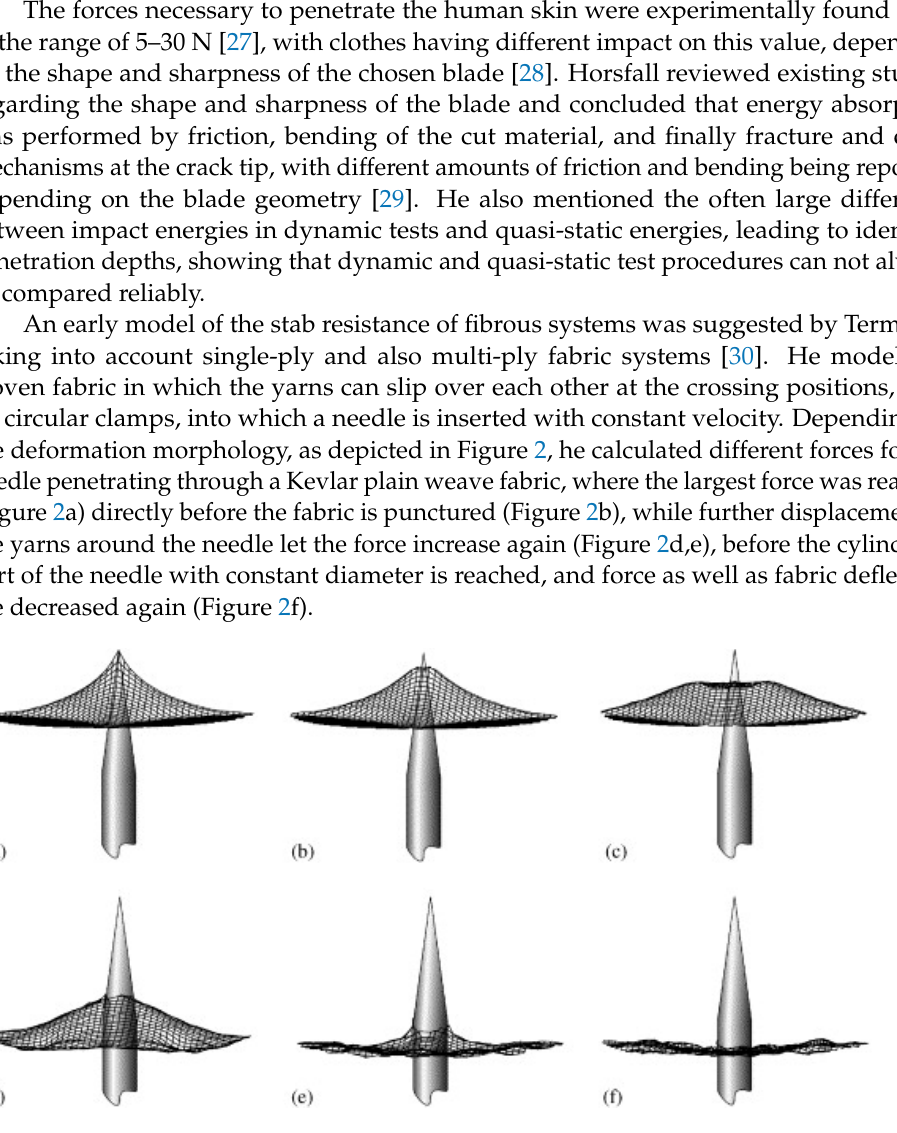
Figure 2. Simulated morphologies of deformation for a needle going through a single ply of plain weave Kevlar fabric. ( a – f ) define increasing displacement. Reprinted from [30], Copyright (2006), with permission from Elsevier.